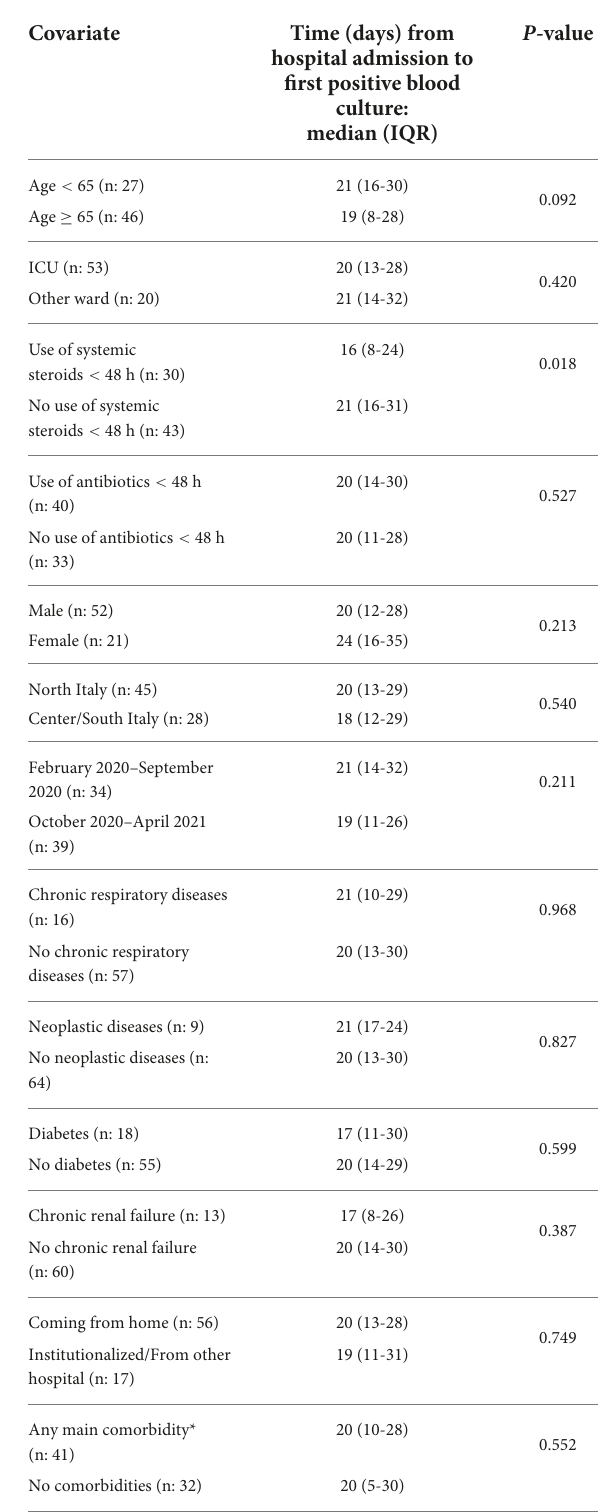
TABLE 1 Population characteristics. TABLE 2 Time from hospital admission to first positive blood culture according to different potentially relevant